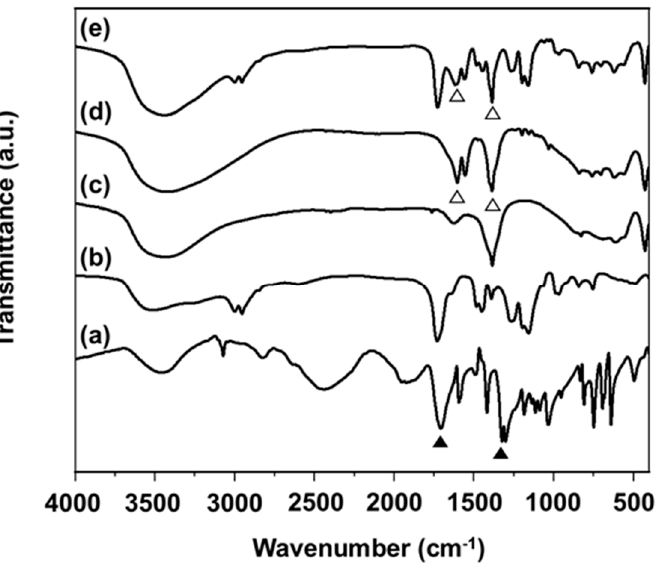
Figure 2. FT-IR spectra of (a) intact NA, (b) Eudragit ® S100, (c) pristine LDH, (f) NA-LDH and Figure 2 . FT-IR spectra of ( a ) intact NA, ( b ) Eudragit ® S100, ( c ) pristine LDH, ( d ) NA-LDH and ( e ) (e) Eudragit ® S100-coated Eudragit ® S100-coated NA-LDH.